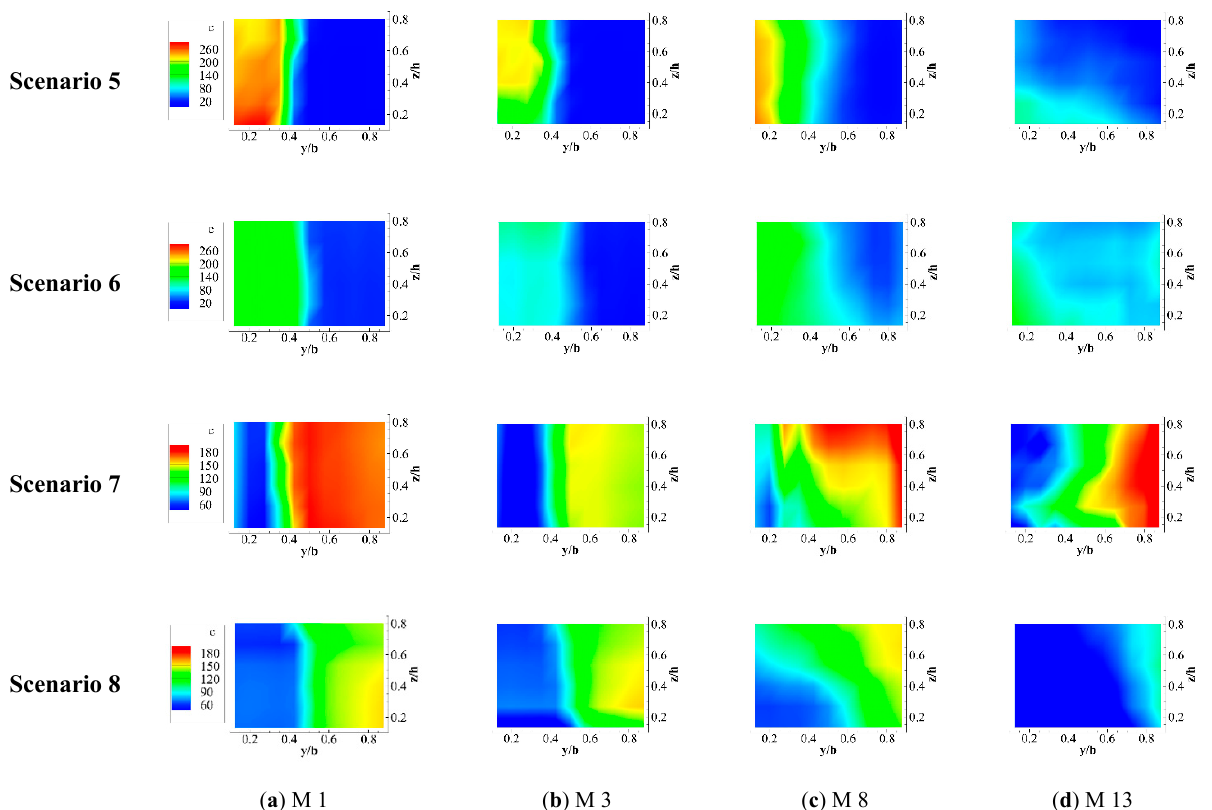
Figure 10. Concentration diagram for the pollutant discharge from the left branch line source under different convergence ratios.